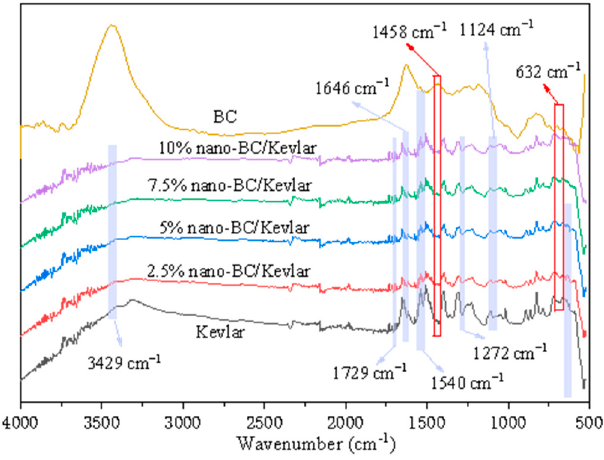
Figure 2. FTIR spectra of nano-BC, Kevlar fiber and the nano-BC/Kevlar MMMs.